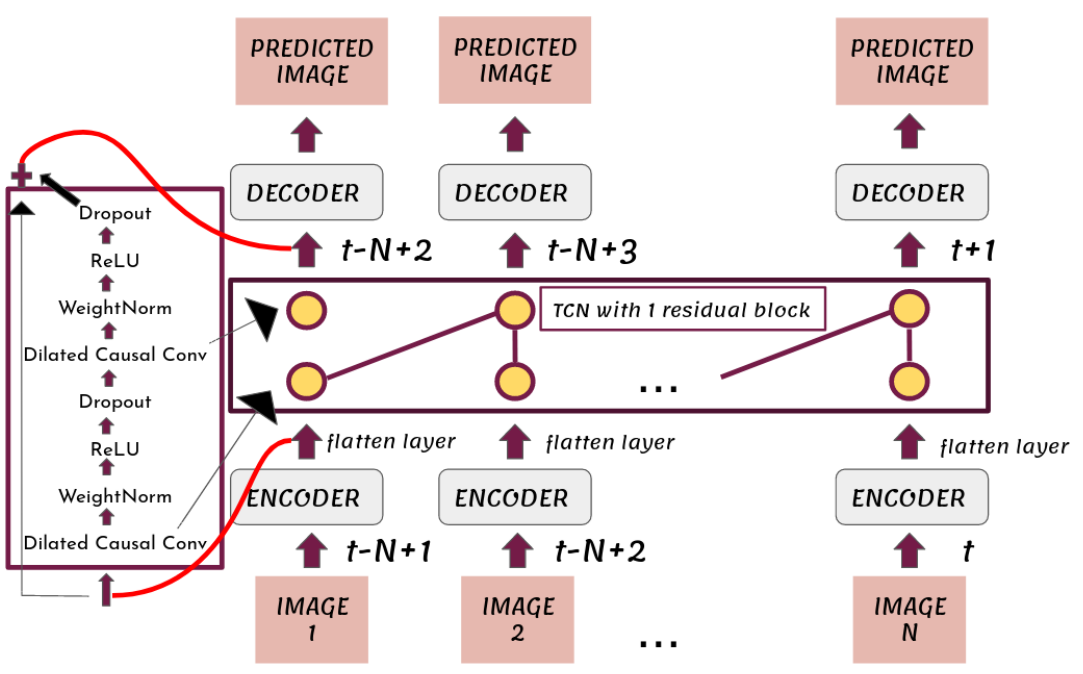
Figure 1. The proposed Embedded Temporal Convolutional Network. The square block at the left shows the inner structure of the used residual